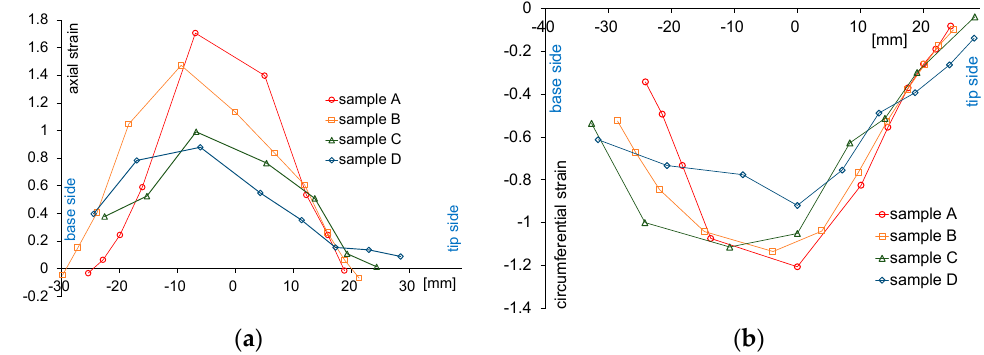
Figure 12. Distributions of ( a ) axial strain and ( b ) circumferential strain in the axial direction of the inner curve. The horizontal axis represents the distance along the curved surface in the axial direction. The origin is at the middle cross section perpendicular to the spindle axis.